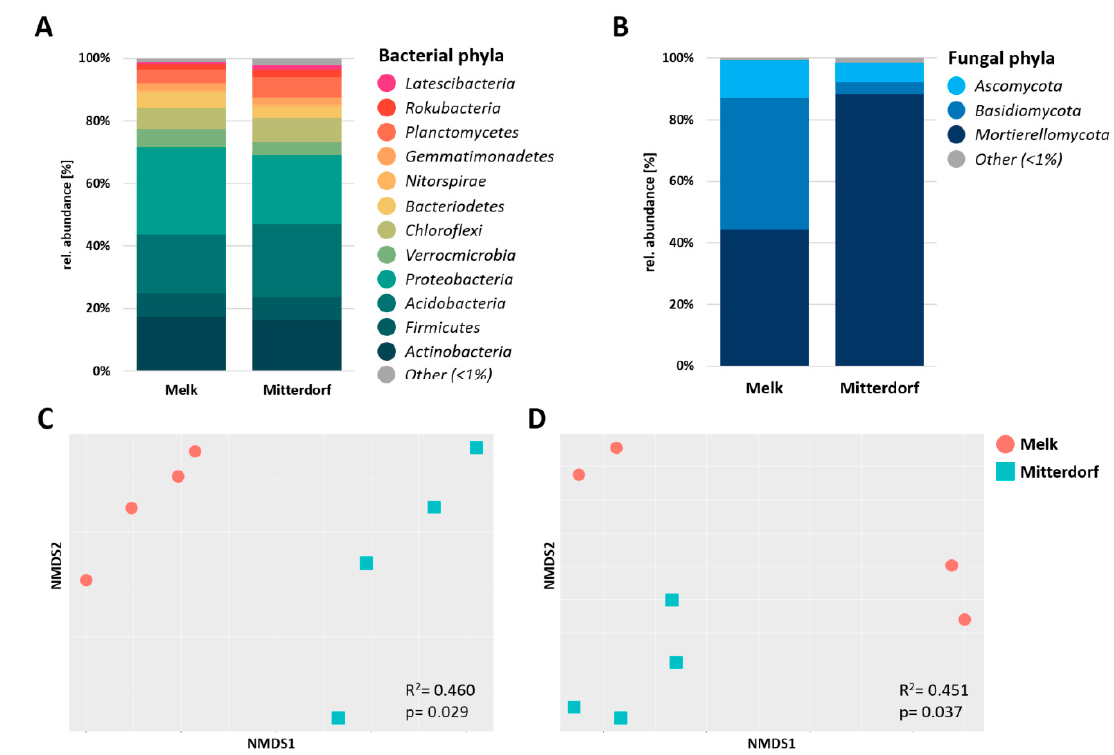
Figure 2. Taxonomic composition ( A,B ) and observed beta diversity ( C,D ) of bulk soil in two different locations. Beta diversity is shown as non-metric multidimensional scaling (NMDS) of Bray–Curtis dissimilarity measures. Significance was tested using PERMANOVA.